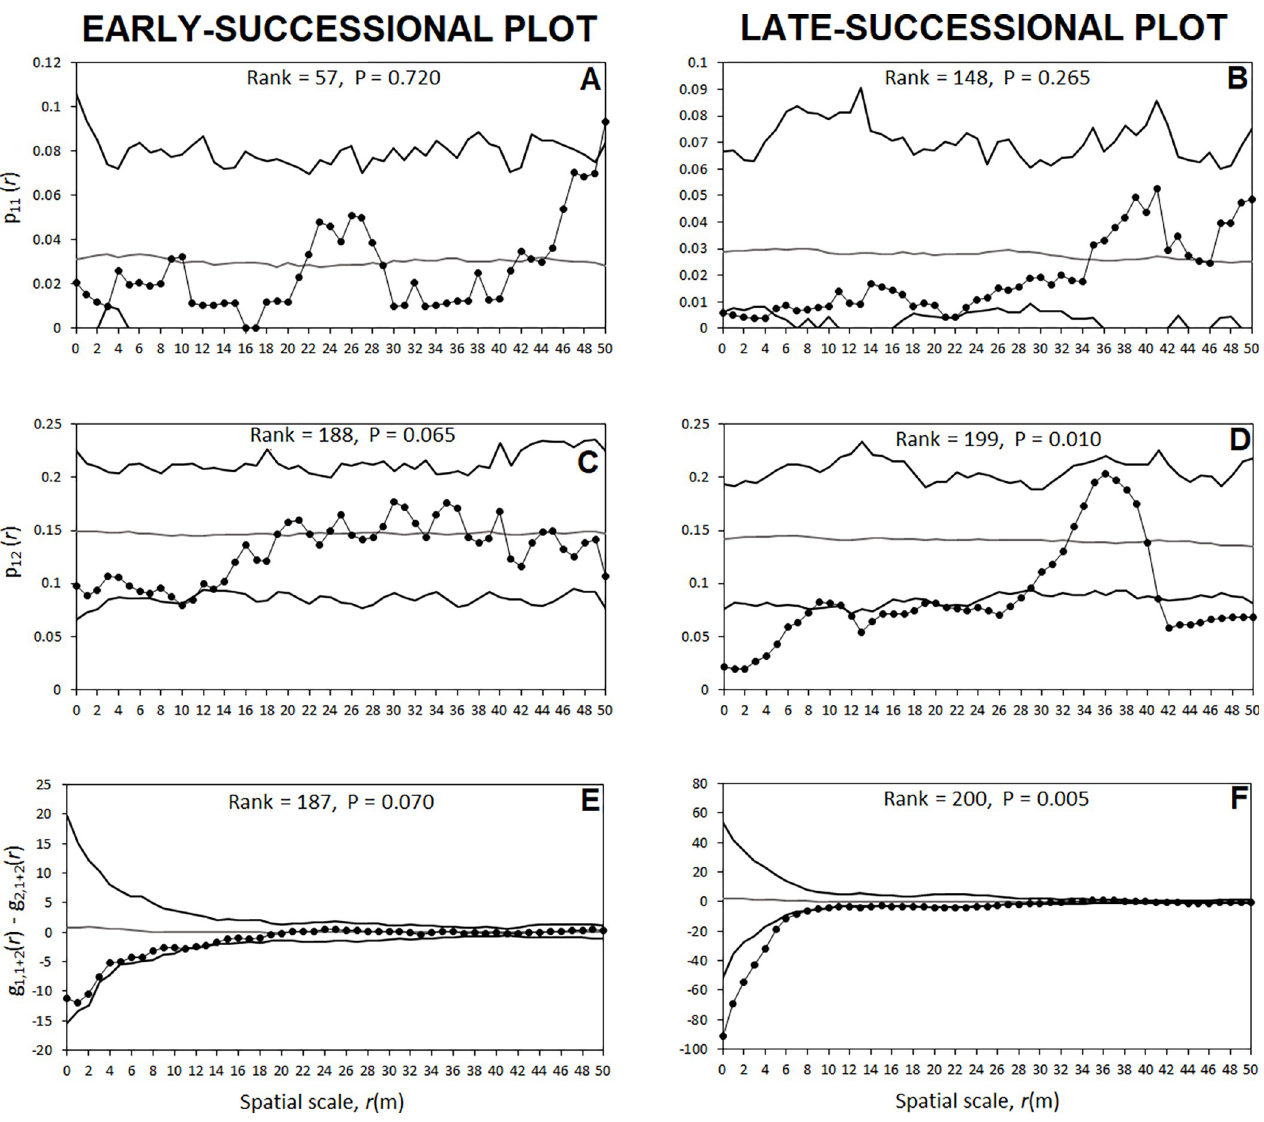
Fig 6. Analysis of feces with seeds in the two study plots (the early and late-successional plots) using mark connection functions as summary statistics. (A, B) The mark connection function p 11 ( r ) gives the conditional probability that, from two C . humilis that are separated by distance r , both are type 1 (i.e., with seeds). (C, D) The mark connection function p 12 ( r ) gives the conditional probability that, from two C . humilis that are separated by distance r , the first is type 1 (i.e., with seeds) and the second is type 2 (i.e., without seeds). (E, F) The test statistic g 1,1+2 ( r )—g 2,1+2 ( r ) compares the density of C . humilis (i.e., 1+2) around C . humilis with seeds (i.e., type 1) with the density of C . humilis (i.e., 1+ 2) around C . humilis without seeds (i.e., type 2). The expected mark connection function statistics (gray line) and the corresponding simulation envelopes (black lines), being the fifth lowest and highest values of the functions created by 199 simulations under random labelling, are also